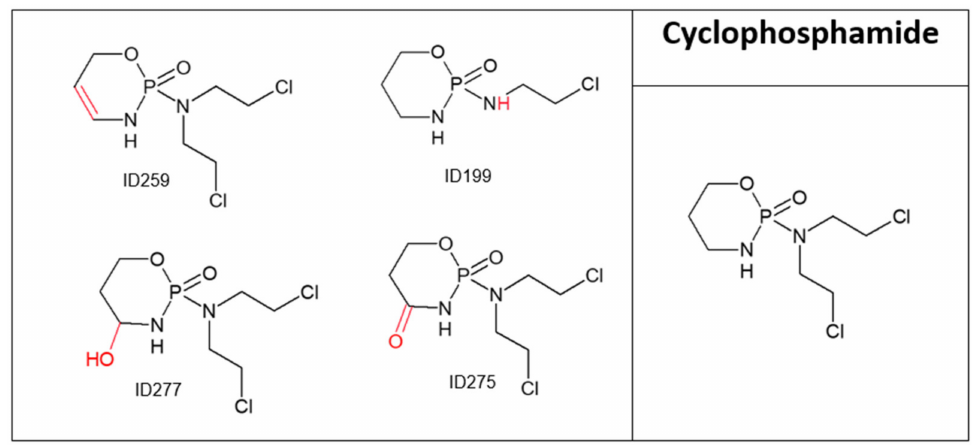
Figure 4. Cyclophosphamide and its major transformation products. Table 4. Cyclophosphamide transformation products’ identification